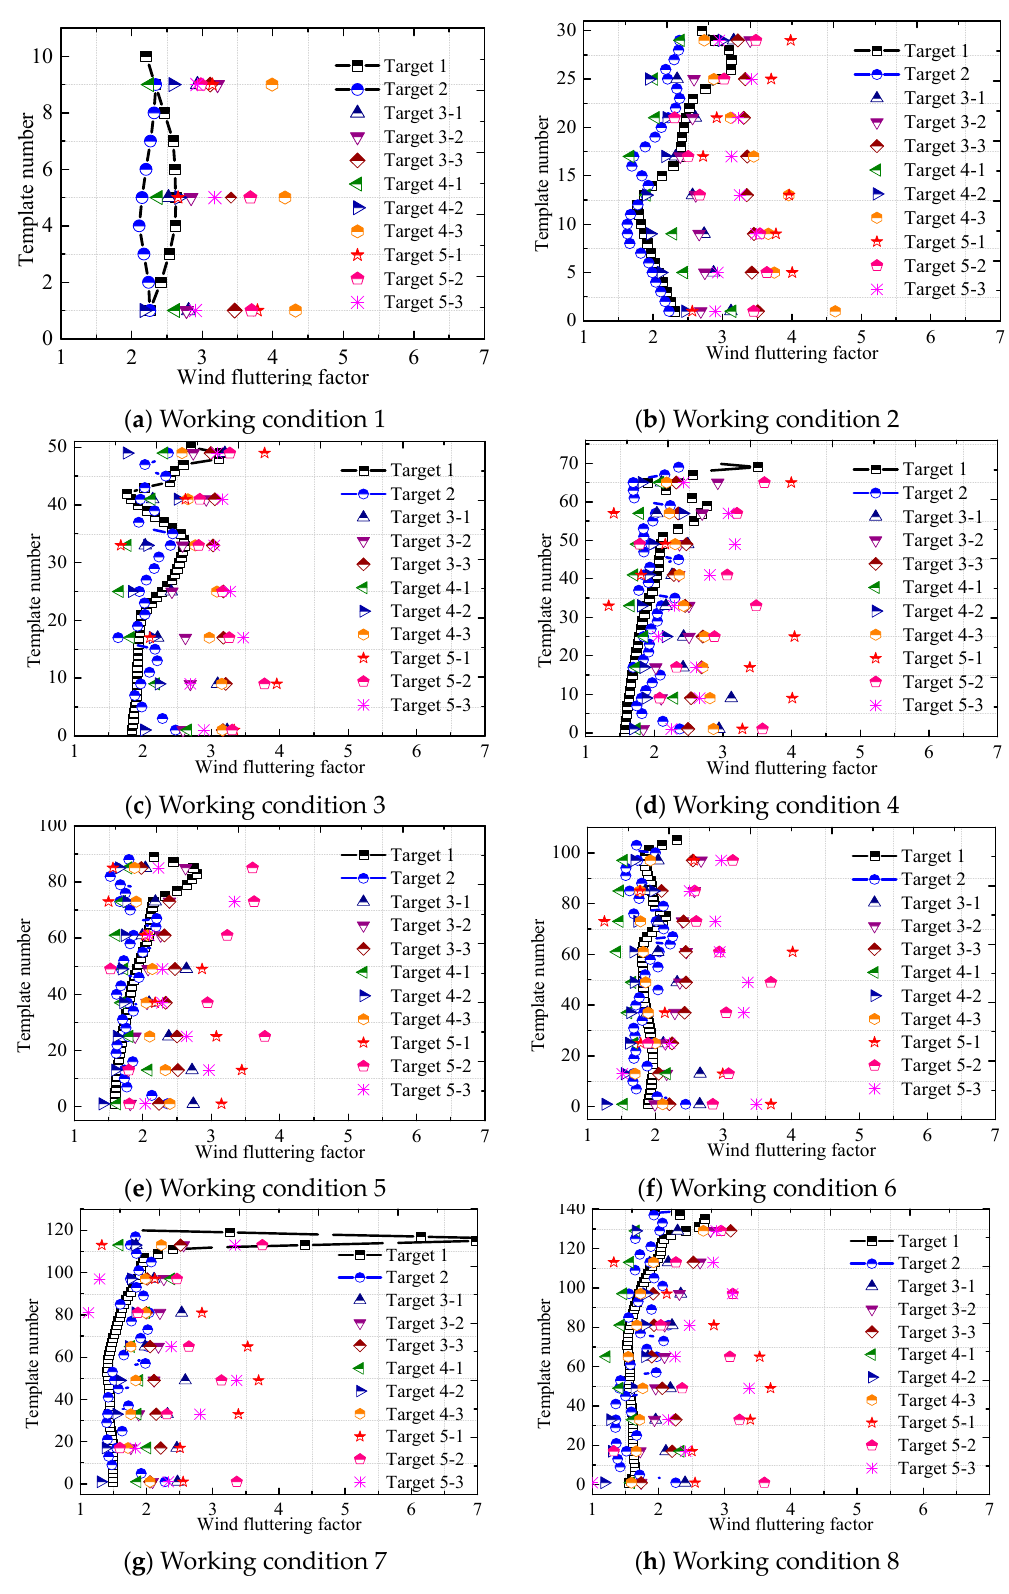
Figure 9. Wind vibration coefficient with meridional heights under five equivalent targets for each working condition.